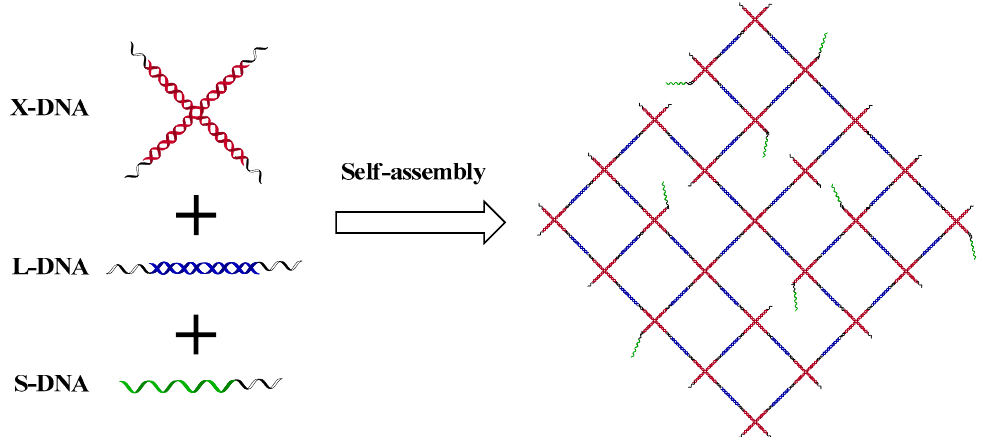
Figure 1. Principle diagram of aptamer-functionalized DNA hydrogel formation. The X-shaped DNA (X-DNA), L-shaped DNA (L-DNA), and single-stranded DNA aptamer (S-DNA) were cross-linked by hybridizing their “sticky ends” (marked in black). The “sticky ends” of the X-DNA were complementary to those of the L-DNA and S-DNA.